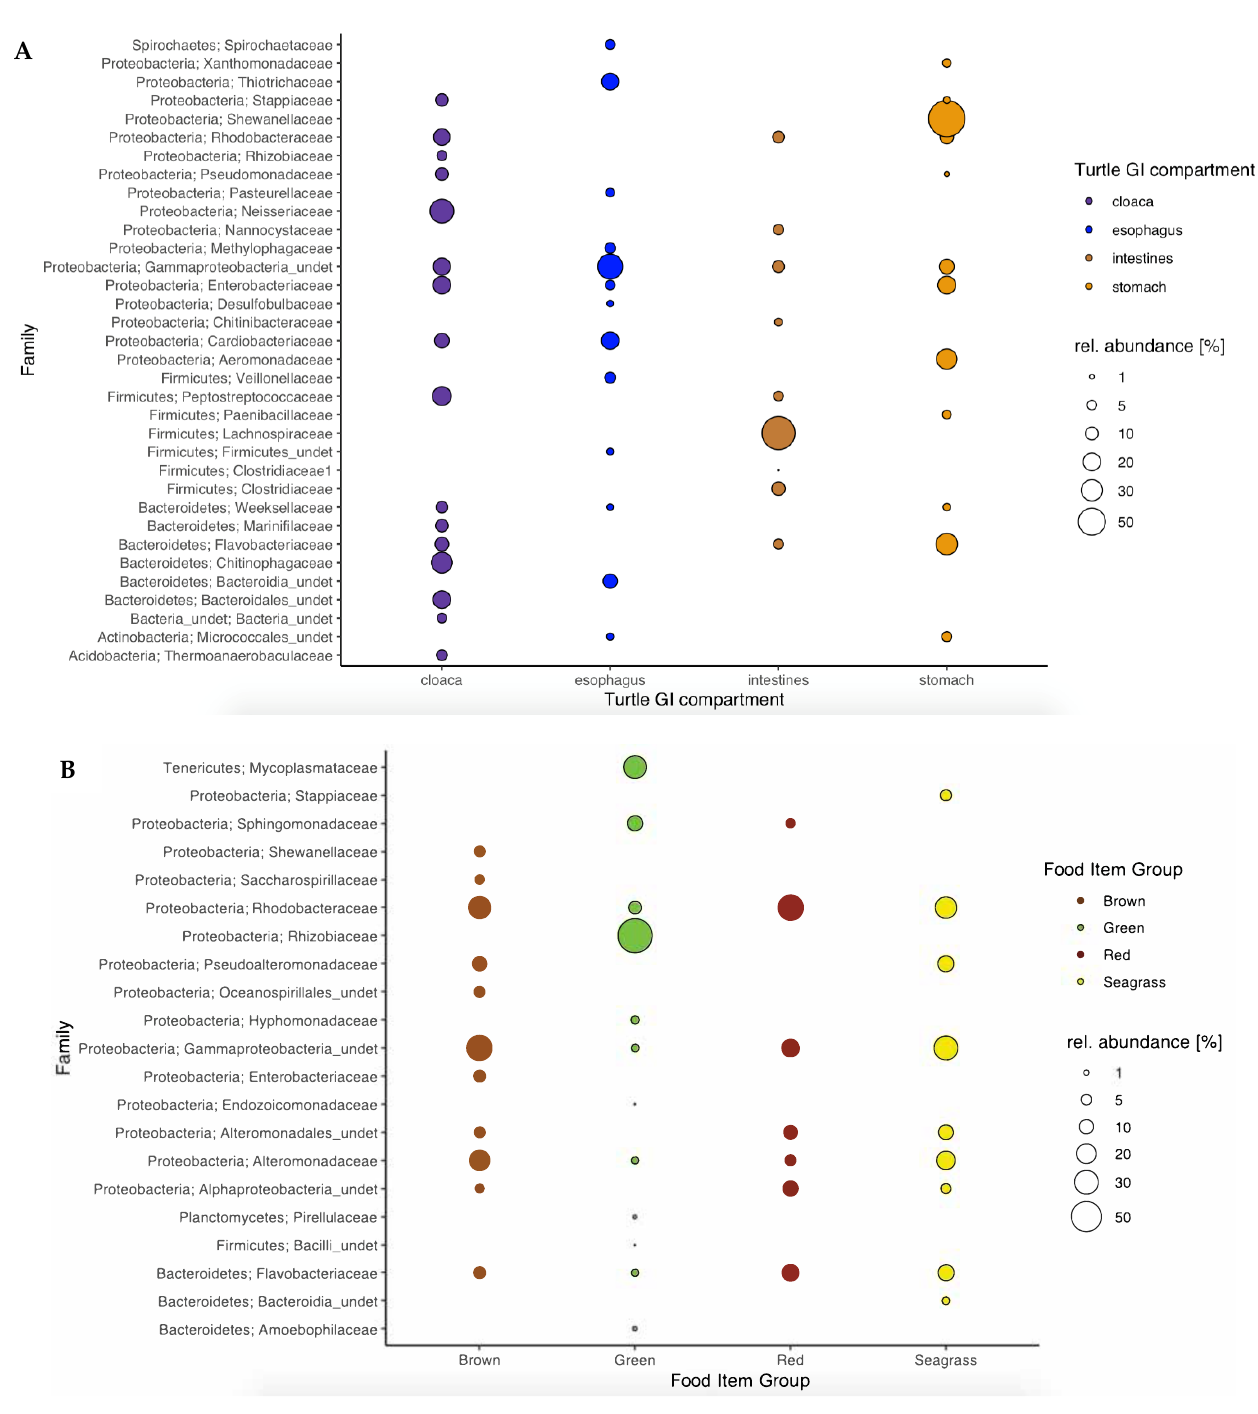
Figure 3. Microbial community composition at the family level ( Y axis, Phylum; Family) of four green turtle gastro-intestinal (GI) compartments ( A ) and of different putative food item groups ( B ). Average of the abundance of the families across the samples of each GI compartment/food item group is represented as relative abundance. Abundance values <1% are not represented.